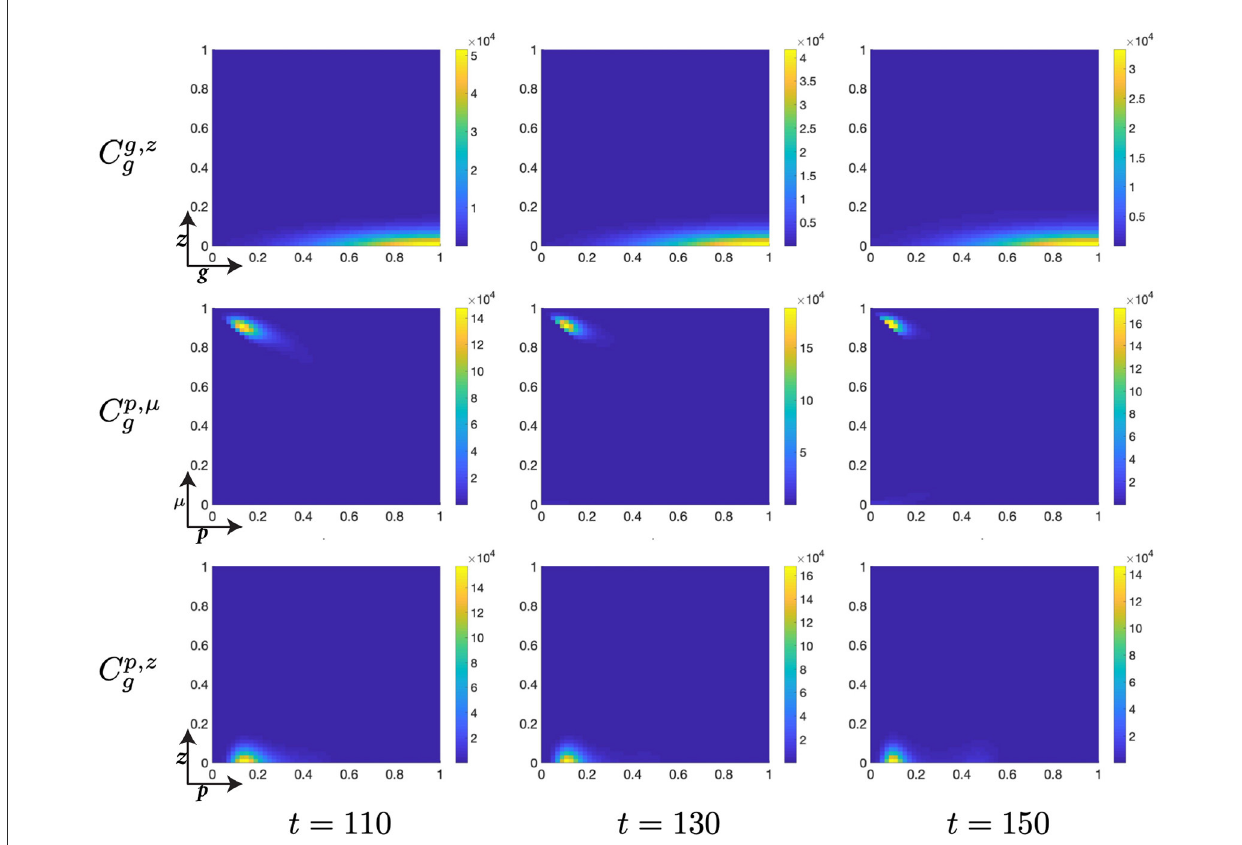
FIGURE11 Structured G-phase cell population given in: the G-cyclin-DNA-damage plane ( g , z ); the p53-mdm2 plane ( p , µ ); and the p53-DNA-damage plane, solved for t 110,130,150 , ∈ { }